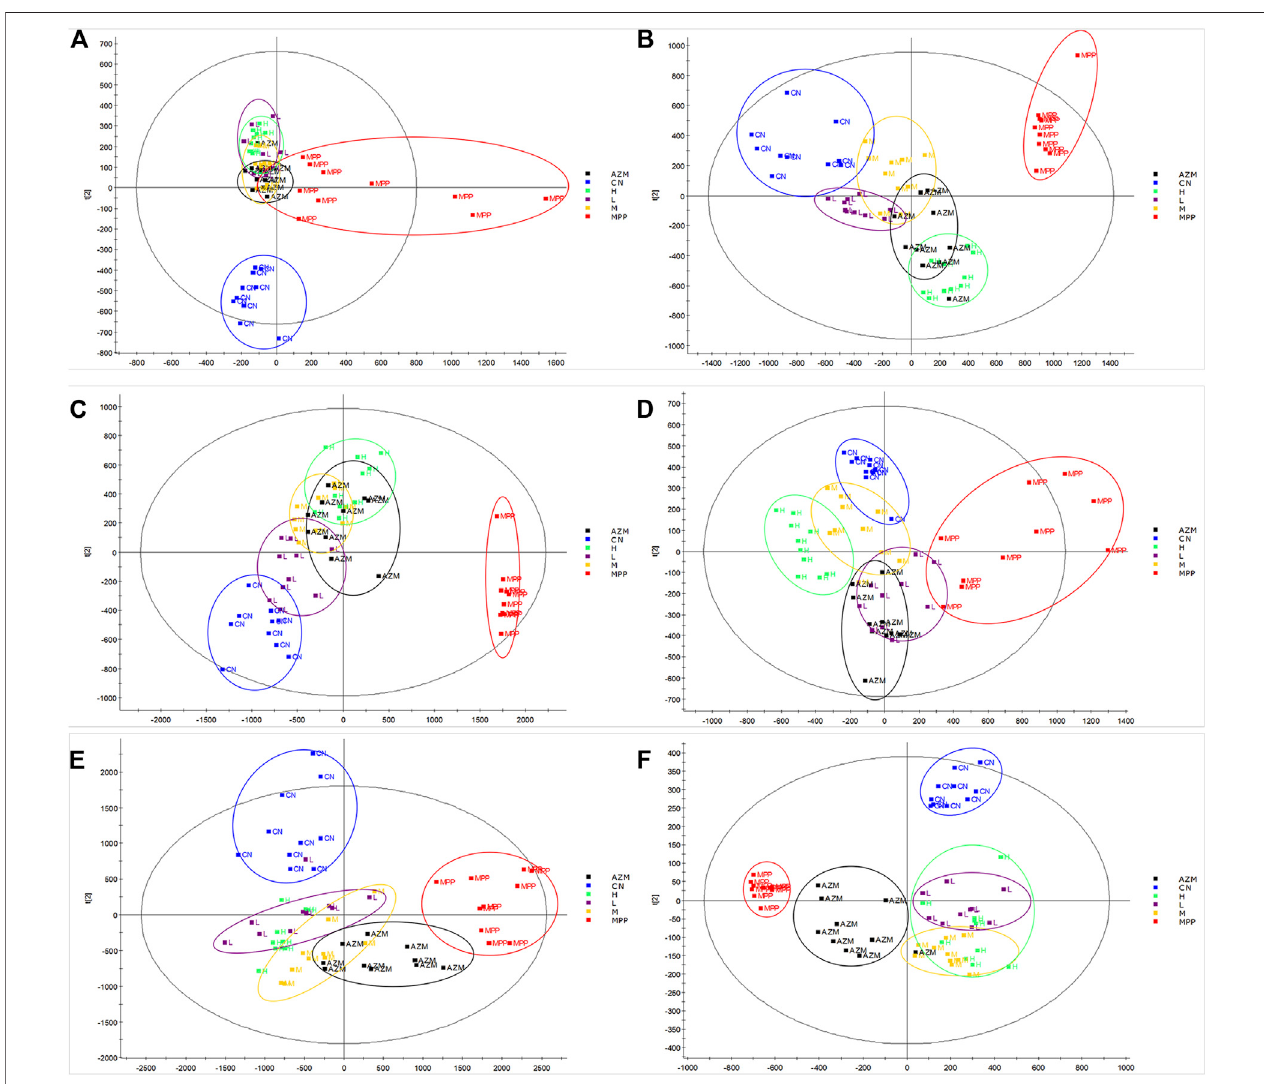
FIGURE 4 | Urine, serum, and lung tissue OPLS-DA images of rats in CN, MPP, QB, and AZM groups. (A) Four groups of urine positive ion mode OPLS-DA diagram (B) Four groups of urine negative ion mode OPLS-DA diagram (C) Four groups of serum positive ion mode OPLS-DA diagram (D) Four groups of serum negativeionmode OPLS-DAdiagram (E) FourgroupsoflungtissueswithpositiveionmodeOPLS-DA (F) fourgroups oflungtissues withnegative ionmodeOPLS-DA. We select 10 samples for each group.